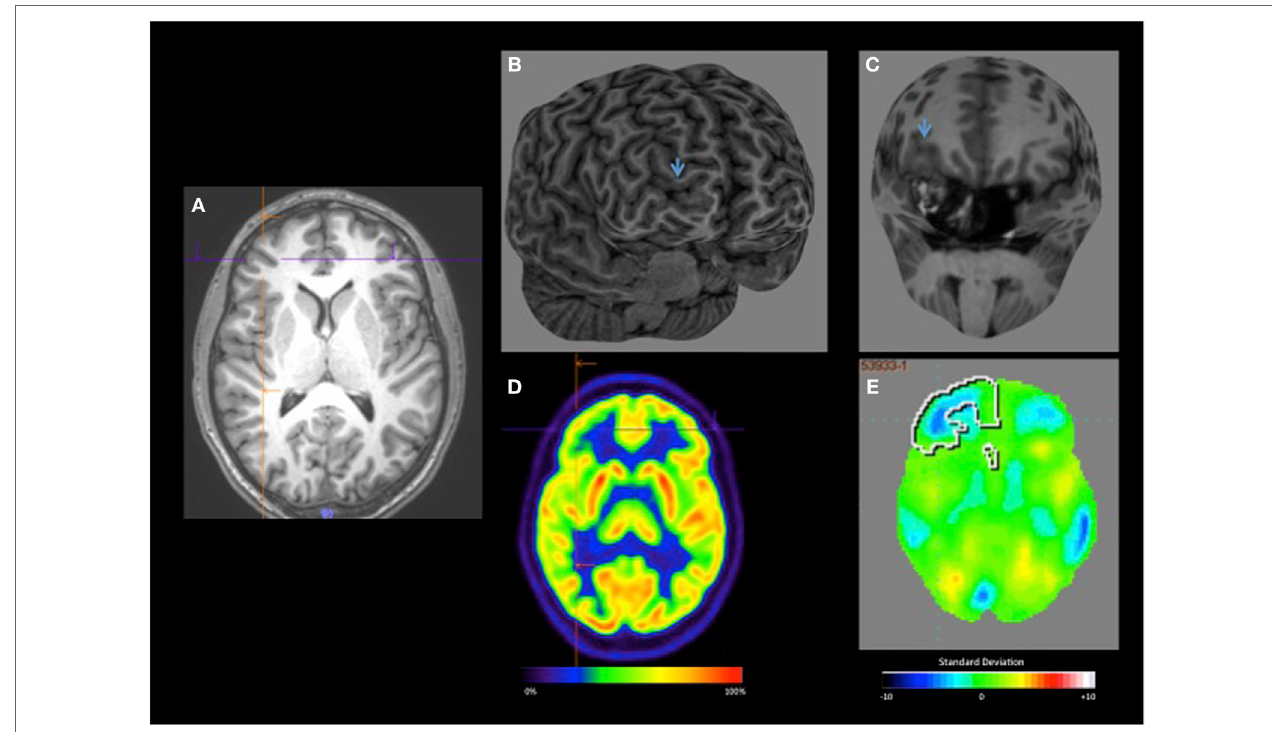
FigUre 4 | (a) Axial T1 negative-MRI (B,c) curvilinear reconstruction shows better the cortical thickening and abnormalities of sulcus and gyrus pattern in the right anterior frontal lobe. (D) visual-positron emission tomography (PET) showing slight hypometabolism in the right frontal lobe. (e) Quantitative-PET shows hypometabolism in the right frontal lobe − 3.7